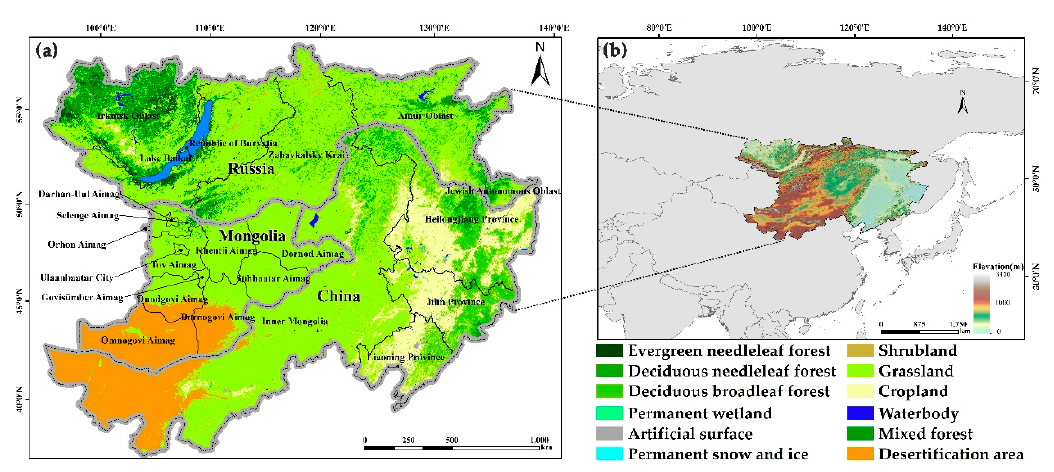
Figure 1. The vegetation distribution ( a ), location and digital elevation model (DEM) ( b ) of the China–Mongolia–Russia Economic Corridor (CMREC) area.